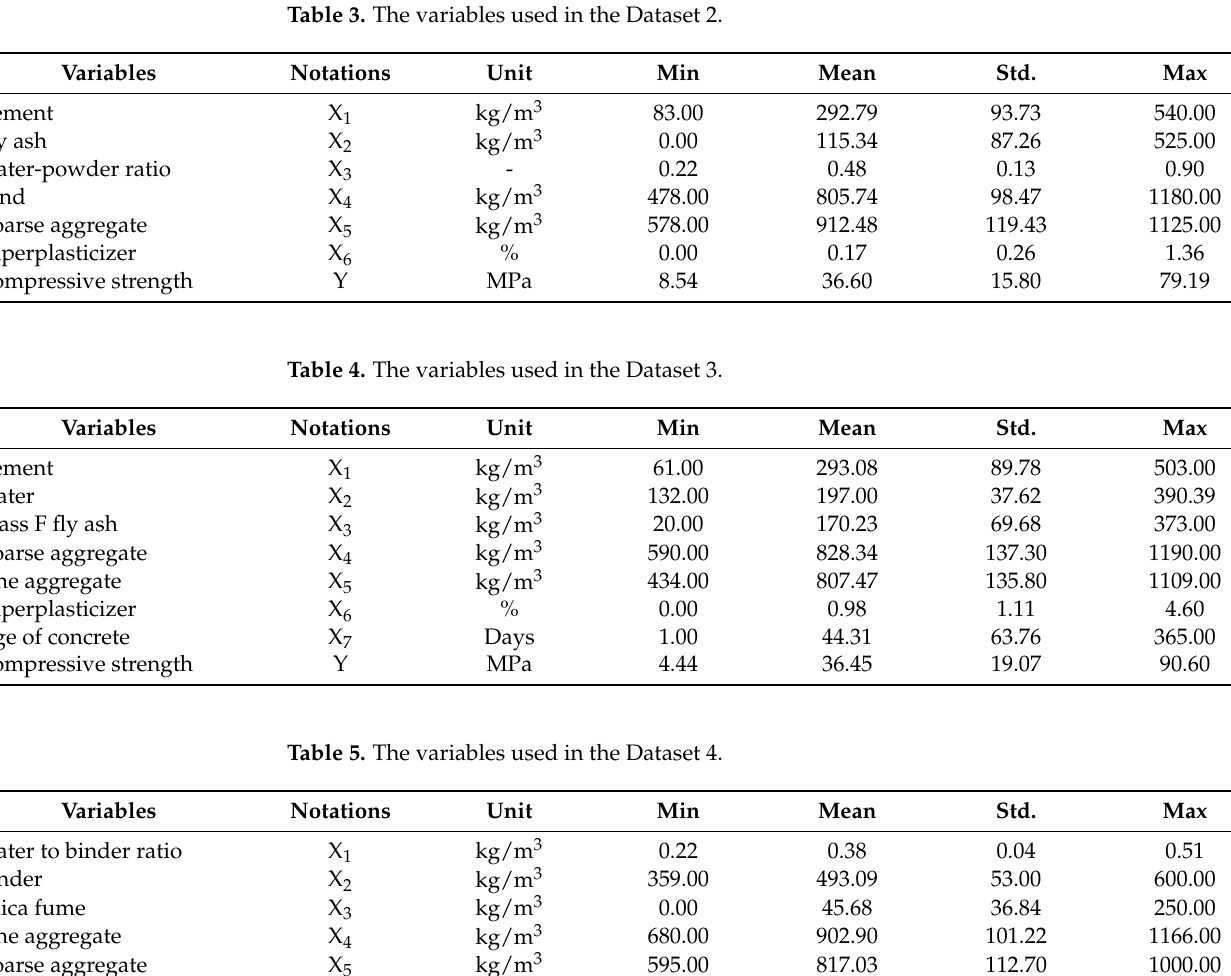
Table 3. The variables used in the Dataset 2.